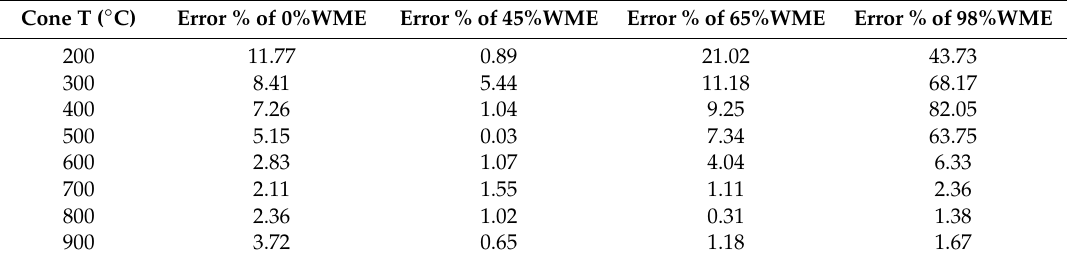
Table 1. Average error percentages for 0%, 45%, 65%, and 98%WME in steady-state.